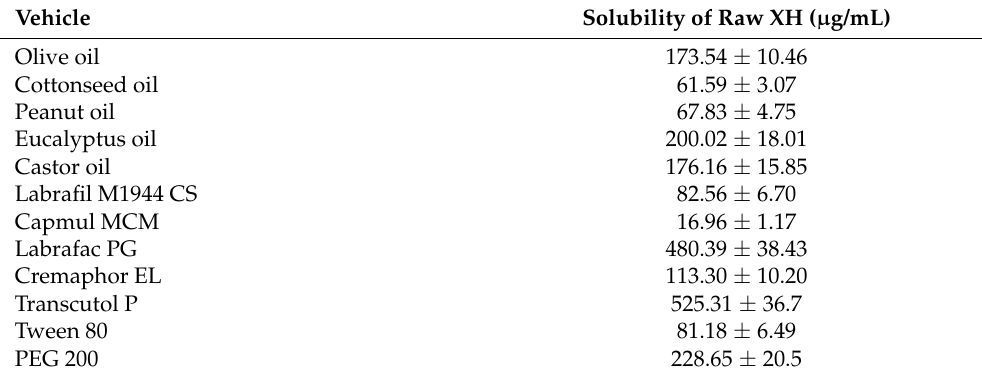
Table 1. XH solubility in different vehicles (data represented as mean ± S.D.; n =